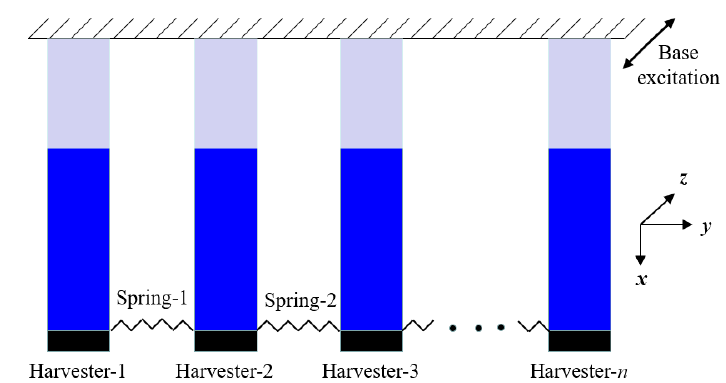
Figure 2. Structural diagram of the NPEHS.